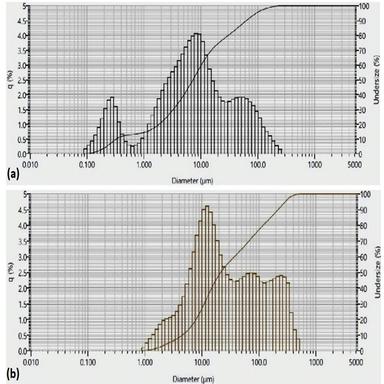
Particle size distribution of (a) FCA (b) GGBFS.